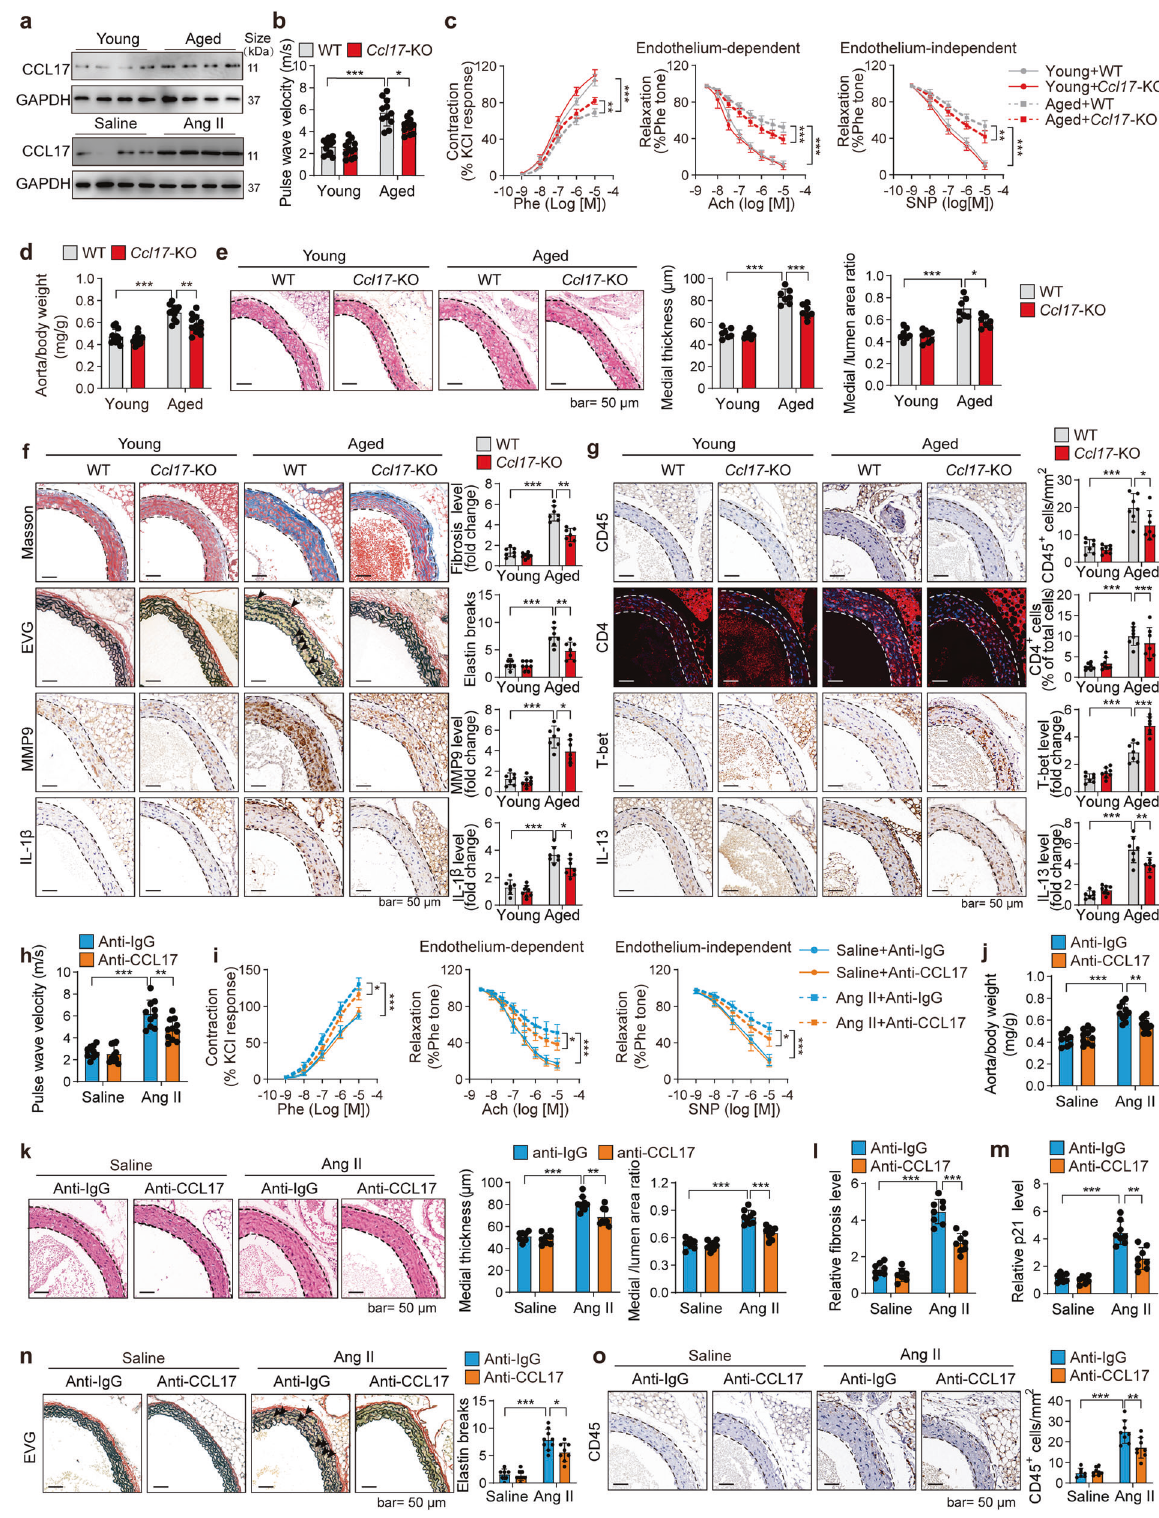
on aging and immunology and may complexify the translation of fi ndings to human vascular function. Finally, although our cross- sectional population study revealed CCL17 level was positively correlated with vascular stiffness, future prospective cohort